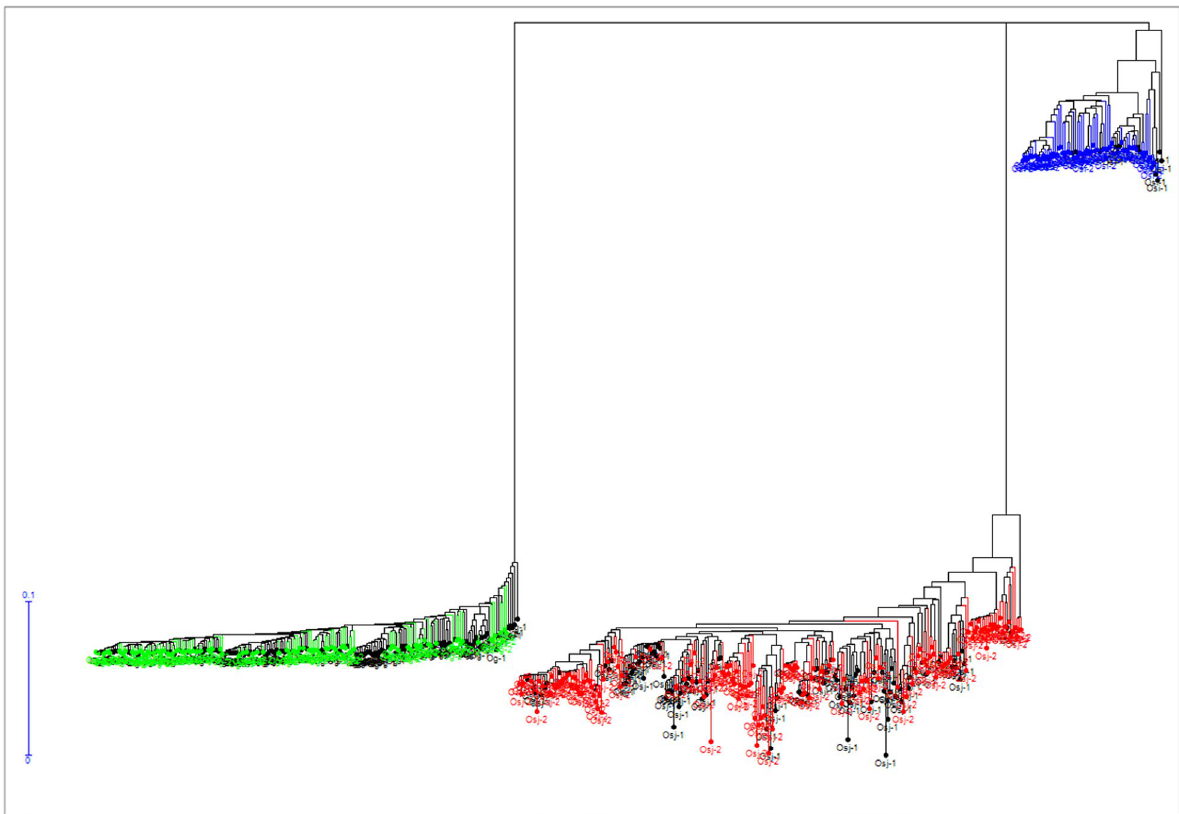
Fig. 4 Unweighted neighbor-joining tree of simple matching distances constructed from genotypes of 530 rice accessions at 1130 SNP loci. Tree branches bearing green, red and blue colors correspond to O. glaberrima , O. sativa indica and O. sativa japonica groups, respectively. Within each branch, accessions from the first collect time ( Og -1, Osi -1 and Osj -1) are shown in